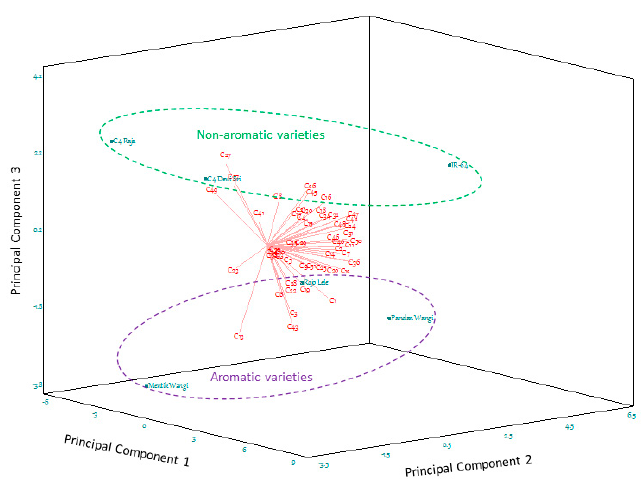
Figure 1. PCA 3D biplot for aromatic (Rojolele, Pandan Wangi and Mentik Wangi) and non-aromatic (IR64, C4 Raja and C4 Dewi Sri) rice samples and the variables used. Fifty-one volatile compounds were used as variables in the PCA (see Table 1).